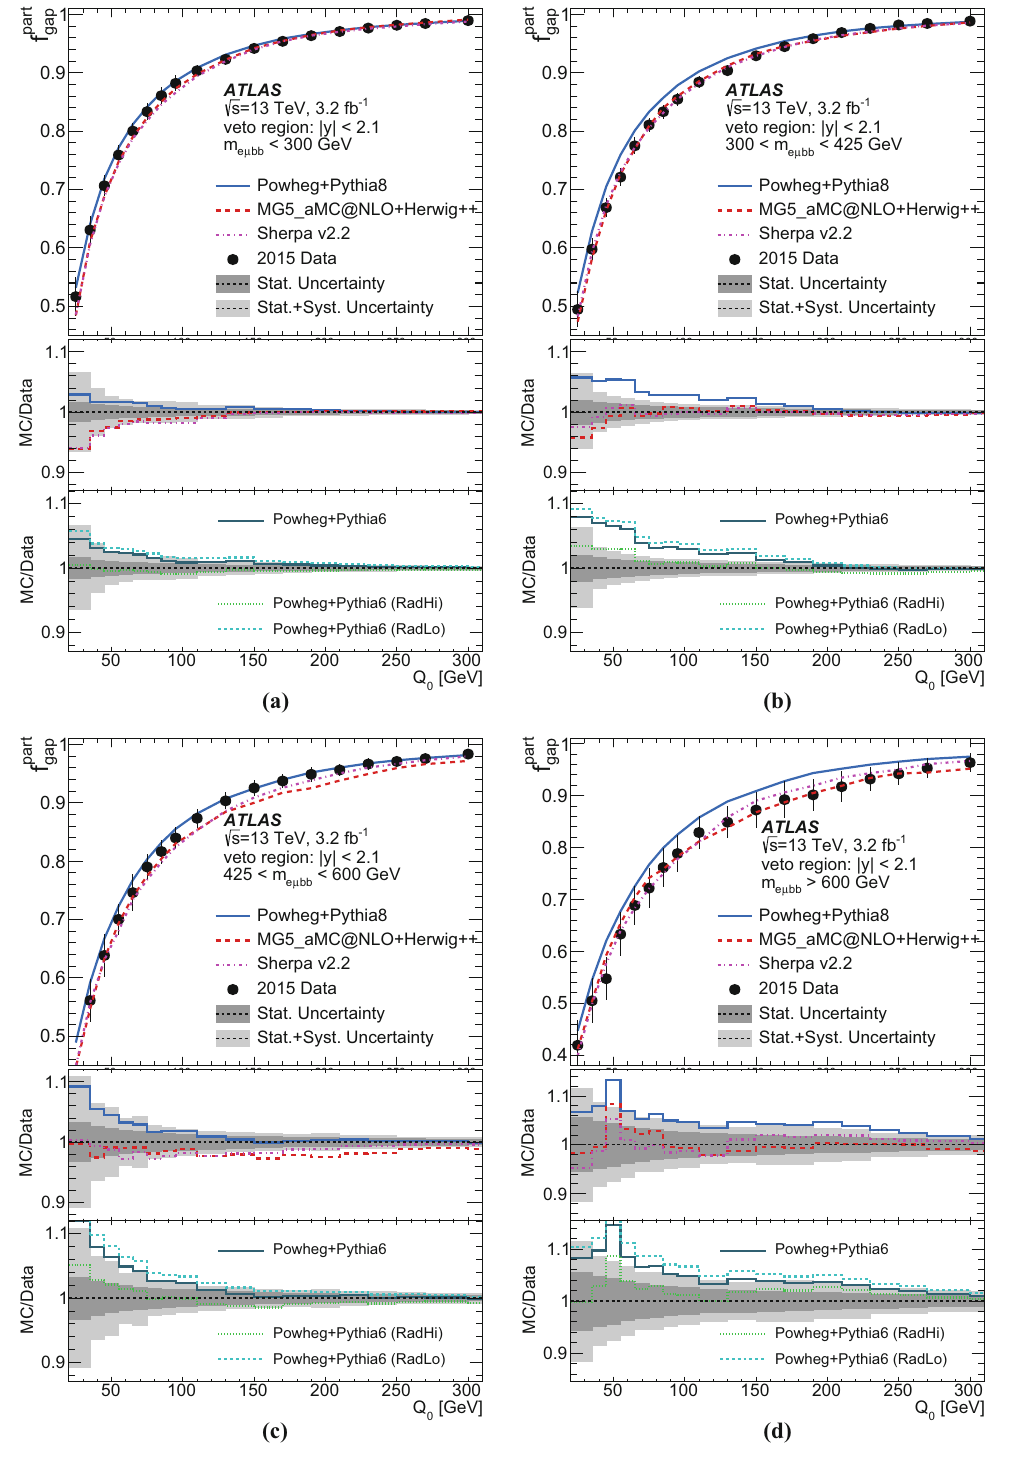
Fig. 14 The measured gap fraction f m ( Q 0 ) as a function of Q 0 in the full central veto region | y | < 2 . 1 for the invariant mass regions a m e μ bb < 300 GeV, b 300 GeV < m e μ bb < 425 GeV, c 425 GeV < m e μ bb < 600 GeV and d m e μ bb > 600 GeV. The data are shown by the points with error bars indicating the total uncertainty, and